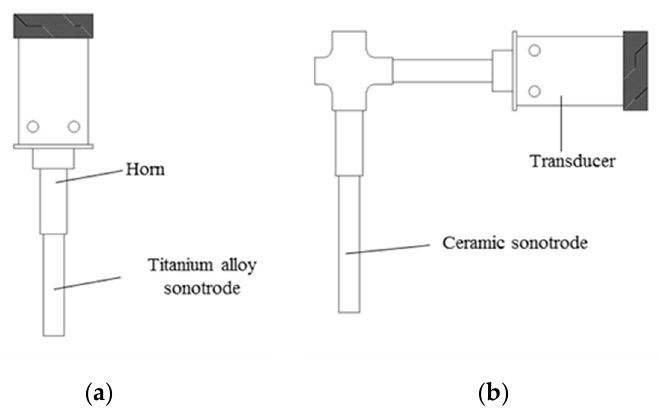
Figure 1. Structure of ultrasonic-introducing sonotrodes: ( a ) straight-rod sonotrode made of titanium alloy; ( b ) L-shaped sonotrode made of ceramic.